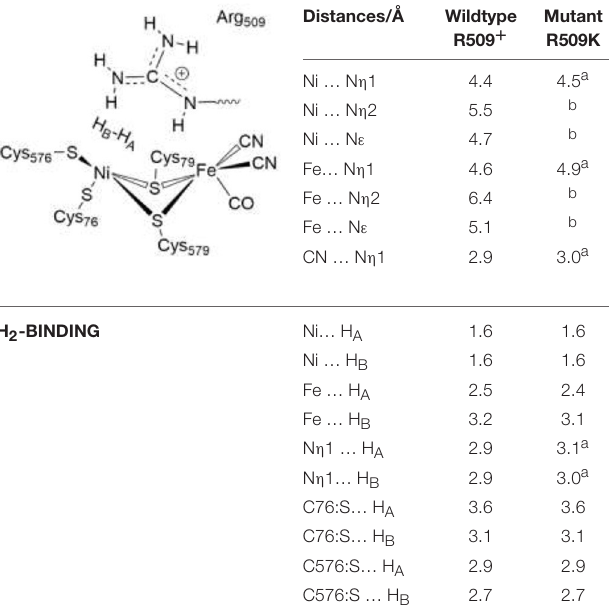
TABLE 5 | Charge distributions in the H 2 Ni-SIa complexes of the wildtype E. coli Hyd-1and the R509K mutant optimized using the larger QM2 region. Atom